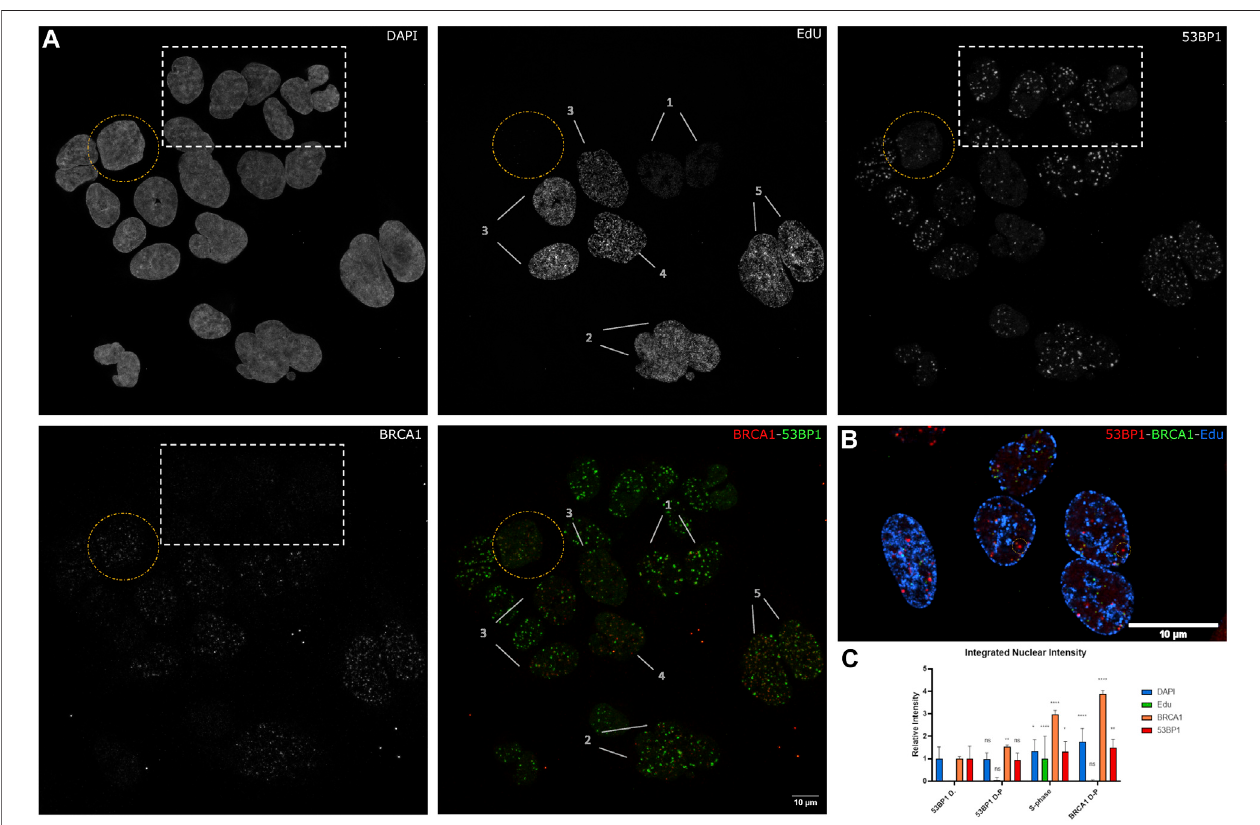
FIGURE2| Therelationshipbetween S-phaseprogression, BRCA1,and 53BP1. (A) U2OScellswerepulselabeledwithEdU 30 min before2 Gyirradiation. Cells were fi xed 1 h postirradiation and immunostained with Click-IT reaction, 53PB1, and BRCA1. (1 – 5) indicate increasing progression through S phase. The yellow circle highlights a BRCA1-dominant non-S-phase cell. The white box indicates 53BP1-dominant non-S-phase cells and (1 – 5) indicate progression through S phase with 1 being the earliest stage and 5 being the latest stage. (B) Examples of late S-phase cells showing 53BP1-rich foci. (C) Quanti fi cation of BRCA1, 53BP1, and DNA intensities with S phase categorized as one and normalized to 53BP1-dominant category. Error bars represent mean ± SD, ns represents nonsigni fi cant( p ≥ 0.01), * p ≤ 0.1, ** p ≤ 0.01, *** p ≤ 0.001, **** p ≤ 0.0001 obtained from pair-wise comparisons of each value relative to the 53BP1-dominant category using a Student ’ s t test. Note that multiwavelength fl uorescent TetraSpeck microspheres were added for alignment corrections. These are present as small fl uorescent dots outside of the cells in all channels. The scale bar represents 10 µm.